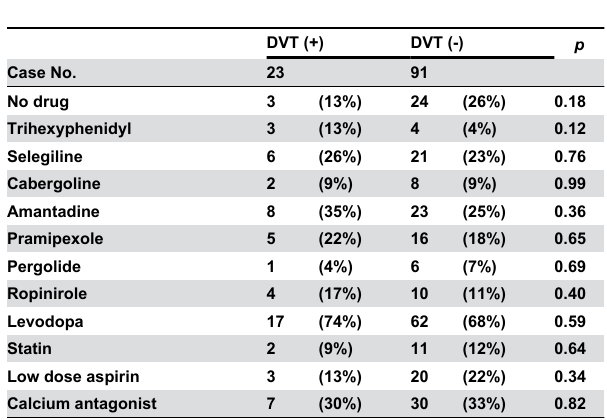
Table 2. Anti-Parkinson drugs and other drug use compared between the DVT-positive group and the DVT- negative group.